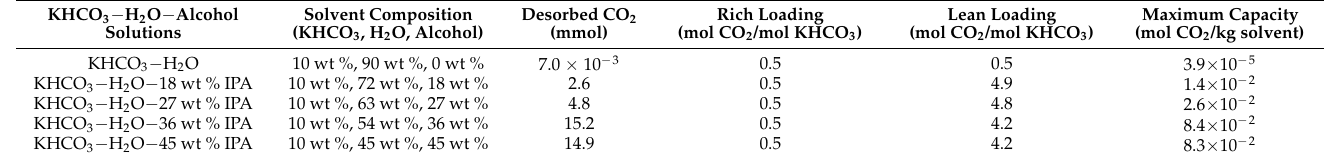
Table 2. Summary of the effects of IPA on CO 2 desorption with KHCO 3 − H 2 O − IPA solutions at 80 ◦ C under 2400 s.